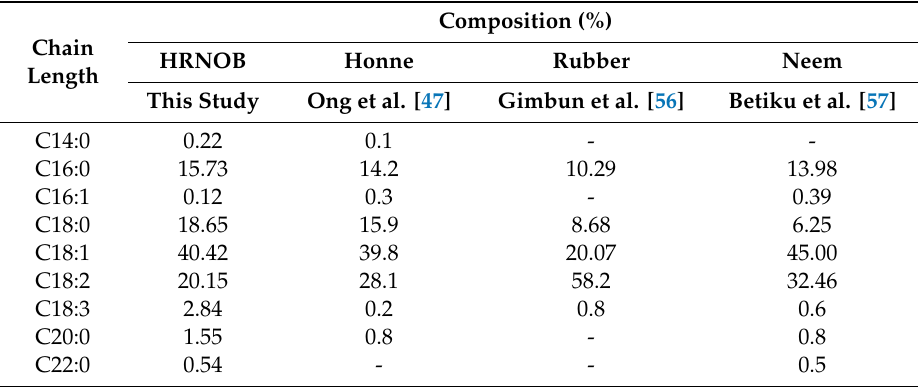
Table 8. Fatty acid profile of HRNOB.